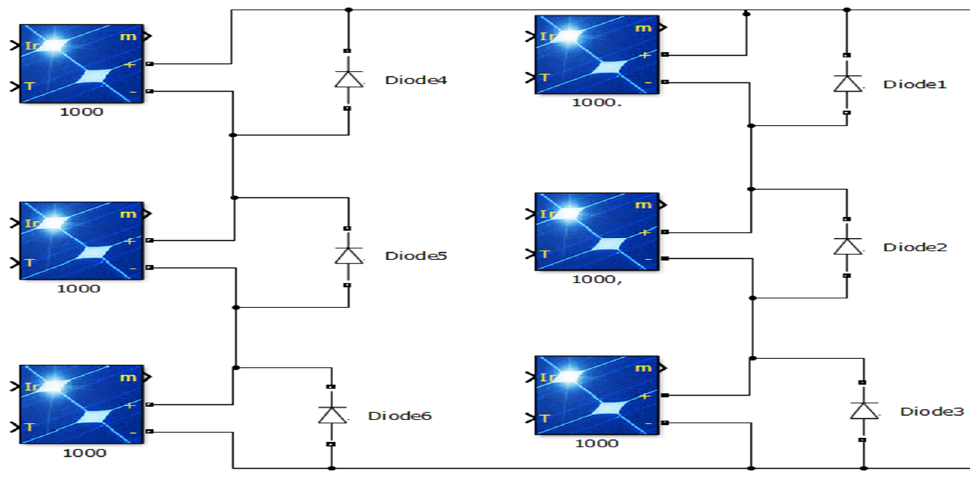
Figure 24. Test cases for 3S2P PV system configuration .